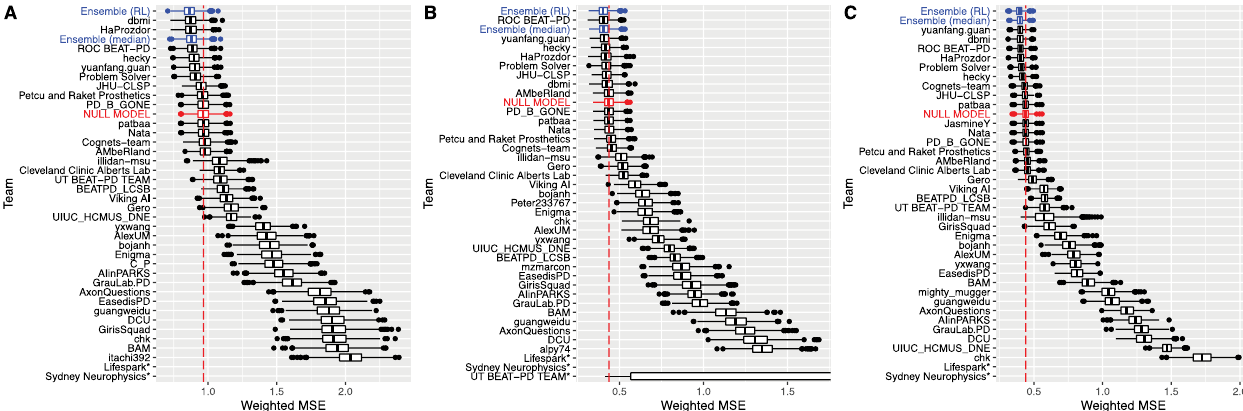
Fig 1. Bootstraps (n = 1000) of submissions for (A) SC1: on/off, (B) SC2: dyskinesia, and (C) SC3: tremor. Team models (black) and their ensembles (blue) are ordered by rank. Boxes correspond to the 25 th , 50 th , and 75 th percentiles, and individual points are displayed beyond 1.5 � IQR (interquartile range) from the edge of the box. For each sub-challenge, a null model (shown in red) estimated as the subject-specific mean of the training labels was used as a benchmark. Models submitted by teams Lifespark and Sydney Neurophysics were outliers, and have not been displayed in order to present greater definition among the top models. For SC2, the UT BEAT-PD TEAM bootstraps have been truncated for the same reason. The non-truncated figures are available in the Supplementary materials.